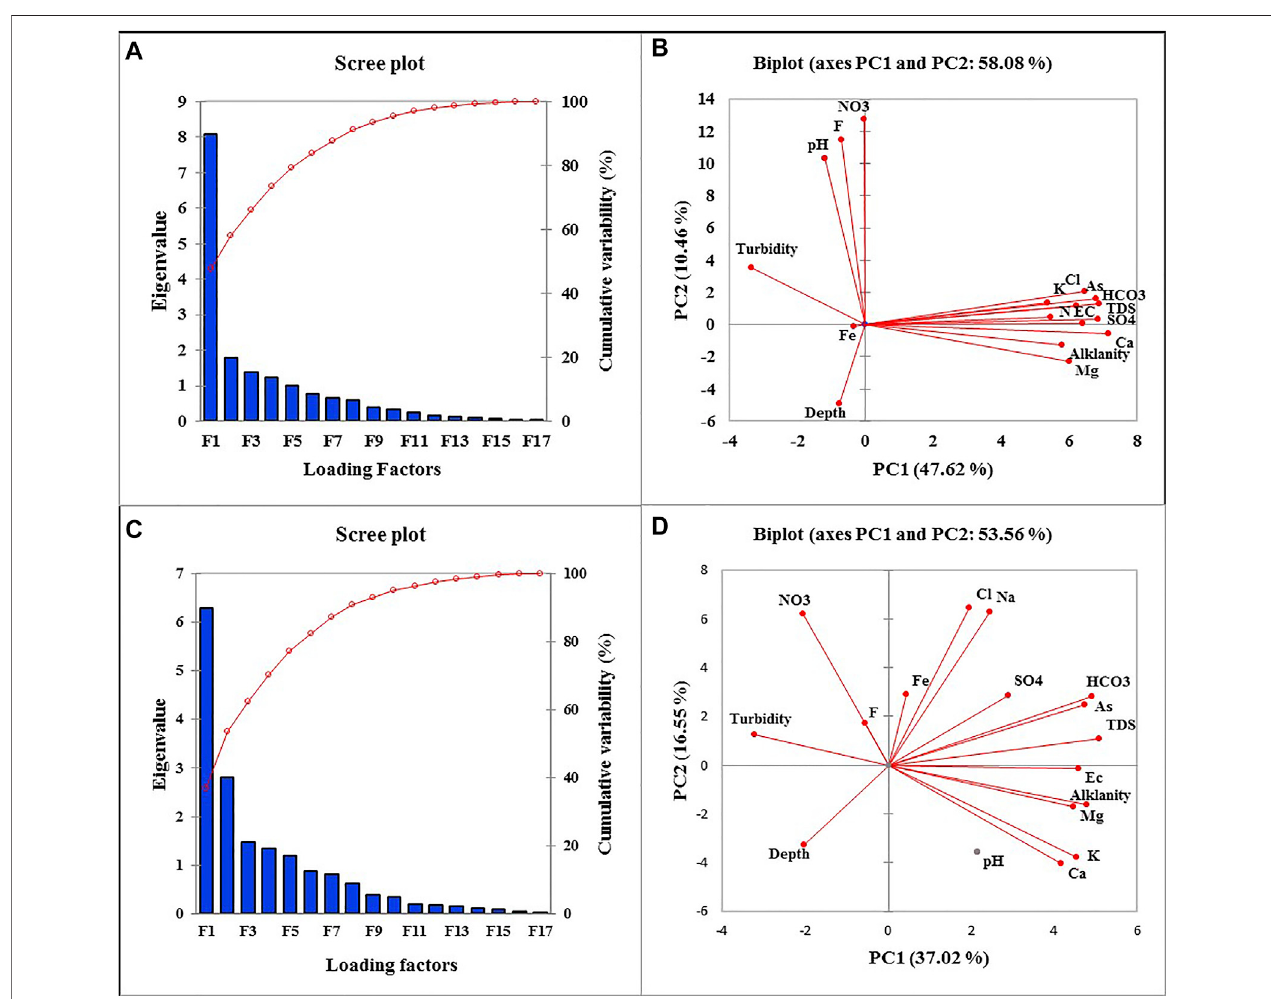
FIGURE4|(A) Sumofallthecalculatedfactors, (B) fi rstandsecondfactorsshows58.02%contributionforGhotki,and (C) showssumofallthecalculatedfactors, (D) fi rst and second factors shows 53.57% contribution for Nawab Shah.